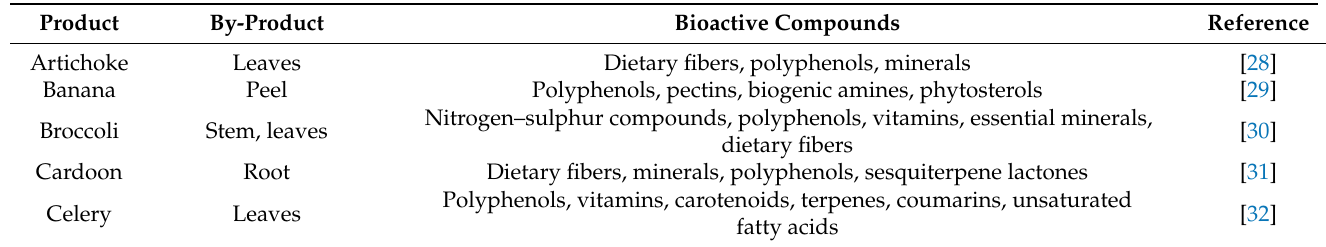
Table 1. The main agri-food by-products and their bioactive